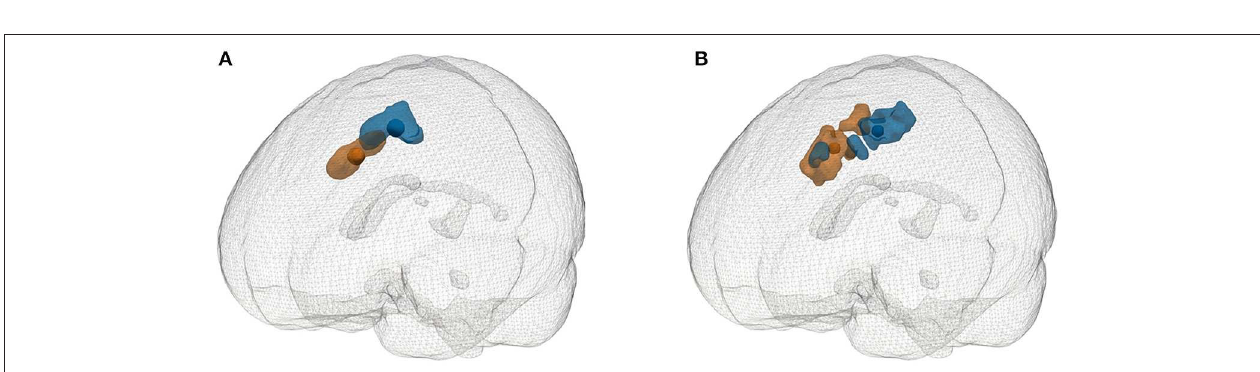
FIGURE 5 | Glass brain rendering of the SFS-related hypometabolic areas (FDR-cor < 0.05) and highly epileptogenic regions ( T -value > 25). (A) Significantly hypometabolic areas compared with the control and corresponding centroids. (B) Highly epileptogenic regions and corresponding centroids. Blue represents group 1, and orange represents group